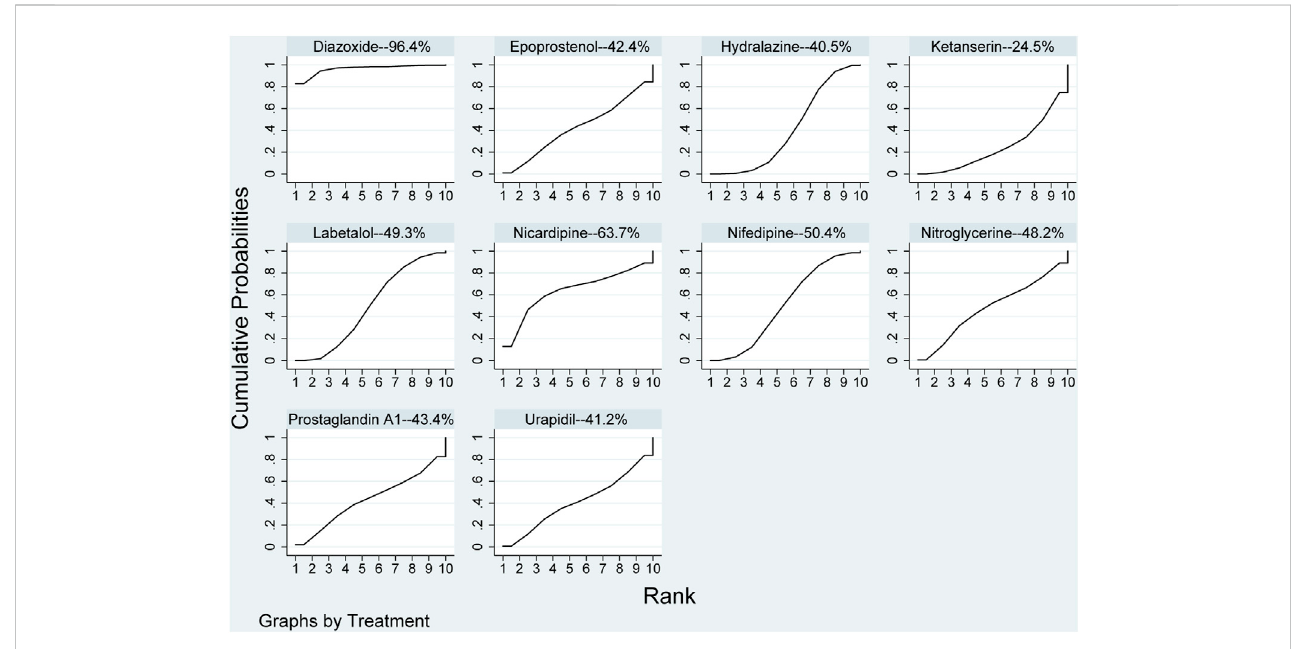
FIGURE 3 Ranking of all pharmaceuticals for achieving target blood pressure. Note: The larger the area under the curve, the more likely it is to be the best intervention. SUCRA, Surface under the cumulative